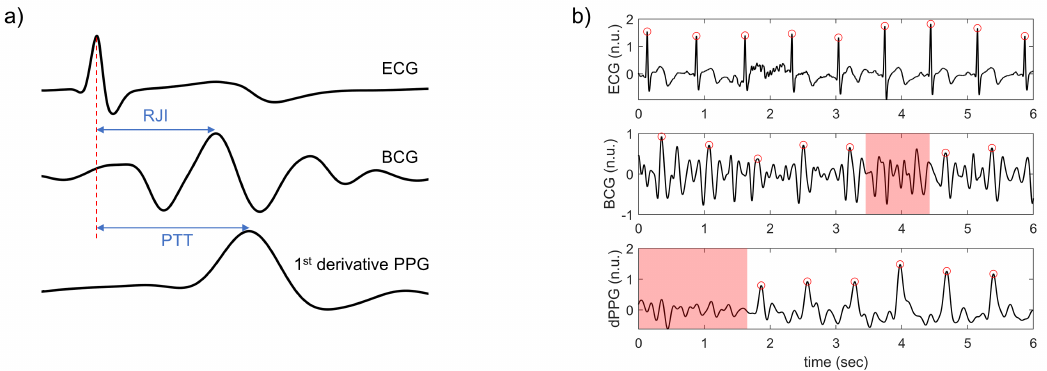
Figure 13. ( a ) example of the calculation of PTT and RJI in one cardiac cycle; ( b ) example of the excluded peaks. Red dots denote each characteristic point, and the red shaded region shows the area where peaks were not